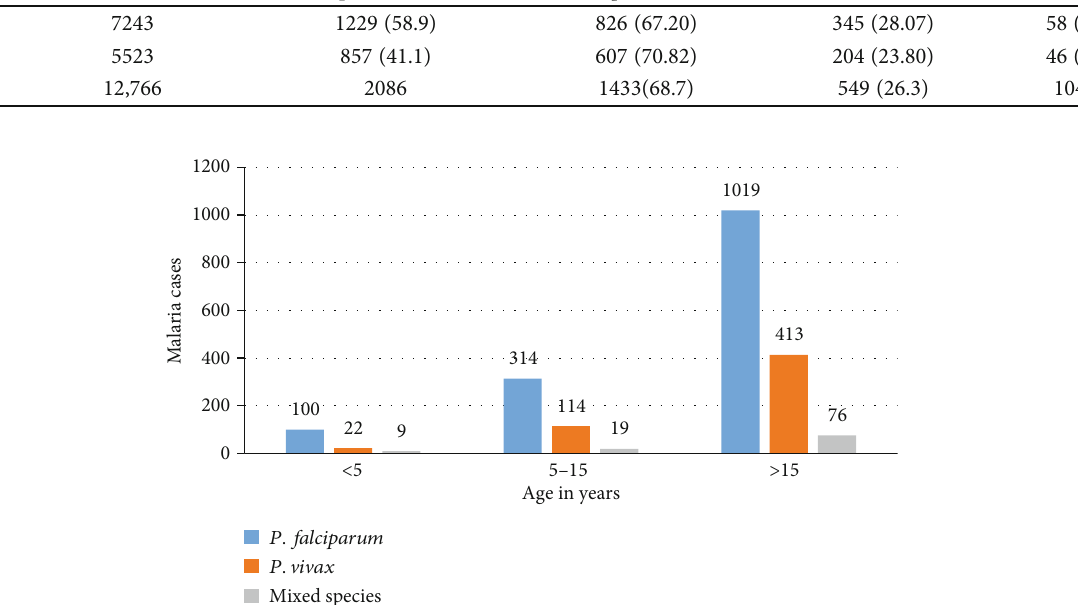
Figure 1: Trends of malaria prevalence in Dembecha Health Center, northwest Ethiopia (2011/12-2015/16). Table 2: Distribution of con fi rmed malaria cases by sex at Dembecha Health Center, northwest Ethiopia (2011/12-2015/16). Sex Total case examined Slide positive no. (%)